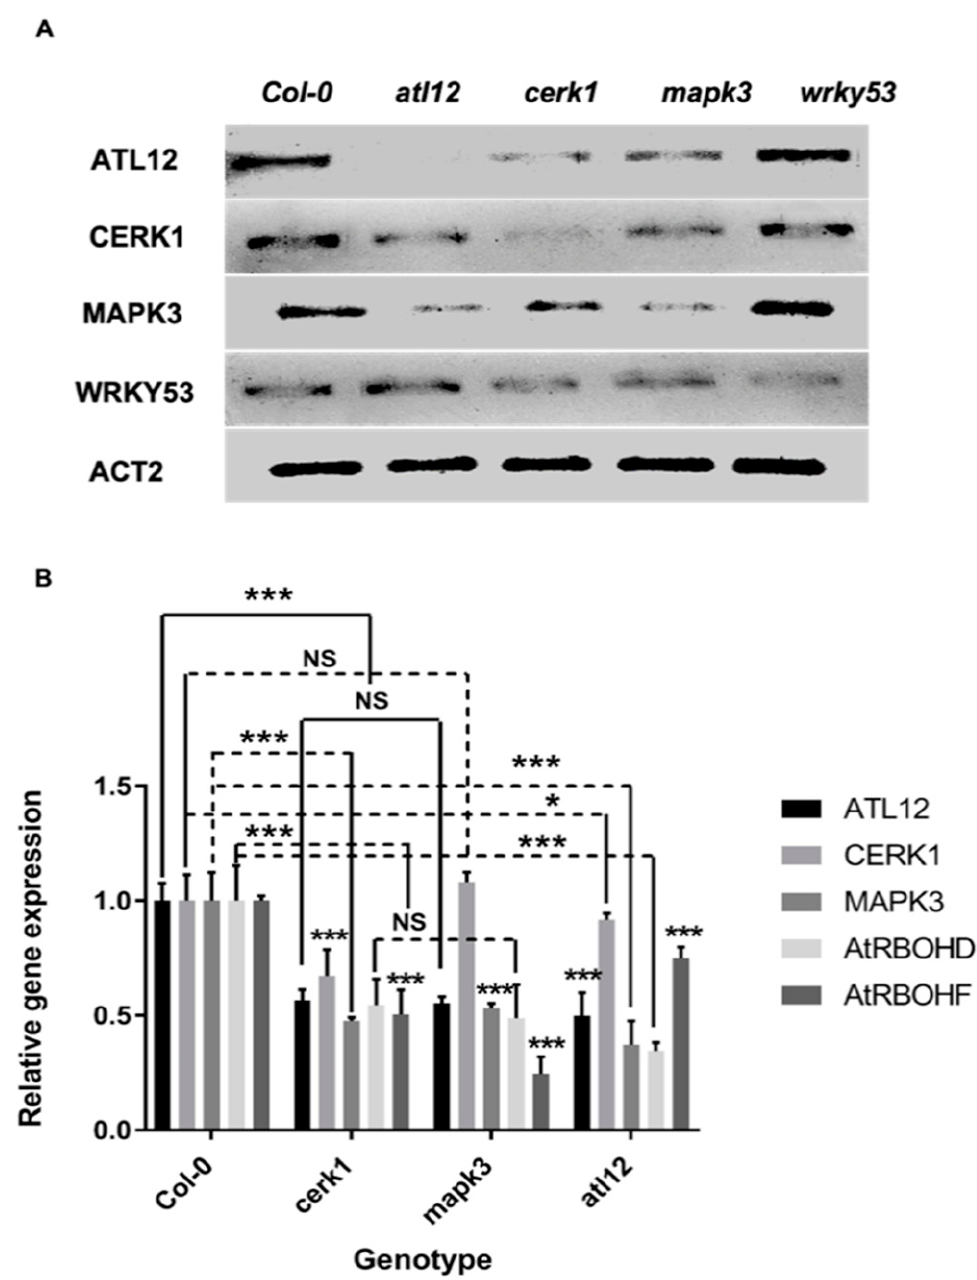
Figure 7. ATL12 is involved with the chitin-mediated signaling pathway through MAP kinase 3 (MAPK3) cascades. ( A ). RT-PCR analysis of marker gene expression in wildtype and mutants. ( B ). qRT-PCR analysis of ATL12 , CERK1 , MAPK3 , AtRBOHD , and AtRBOHF expression in wildtype and mutants. Experiments were repeated three times. *** indicates p < 0.001; * indicates p < 0.05 and NS indicates not